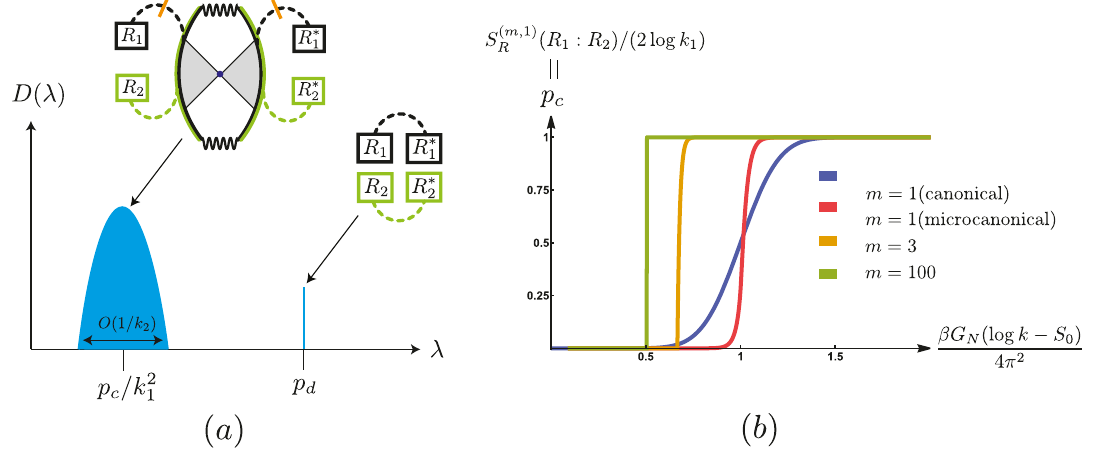
Figure 3 . The main result: (a) the reflected entanglement spectrum of ρ AA ∗ in the canonically |√ purified state ρ AB i is a mixture of two superselection sectors: a single pole of weight p d corre- sponding to the disconnected purification, and a mound of approximately k 2 k 1 < k 2 ) with weight p c corresponding to a connected purification involving a closed universe with the entanglement wedge cross section denoted in orange. (b) The probability of the connected pu- rification p c as we vary k across the Page transition. We show analytic plots for the microcanonical and canonical ensemble. The latter shows a spread in the phase transition of O show plots for p c when considering the ( m, 1) -Renyi reflected entropy; these undergo sharp transi- tions at m -dependent locations in the canonical